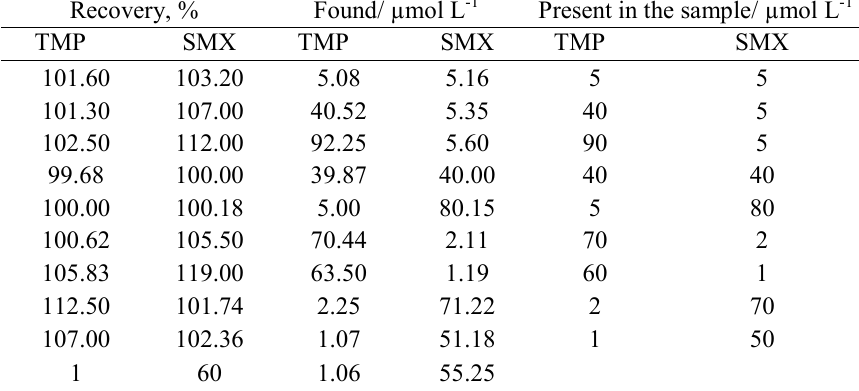
Table 2. Determination of SMX and TMP in some synthetic mixtures.